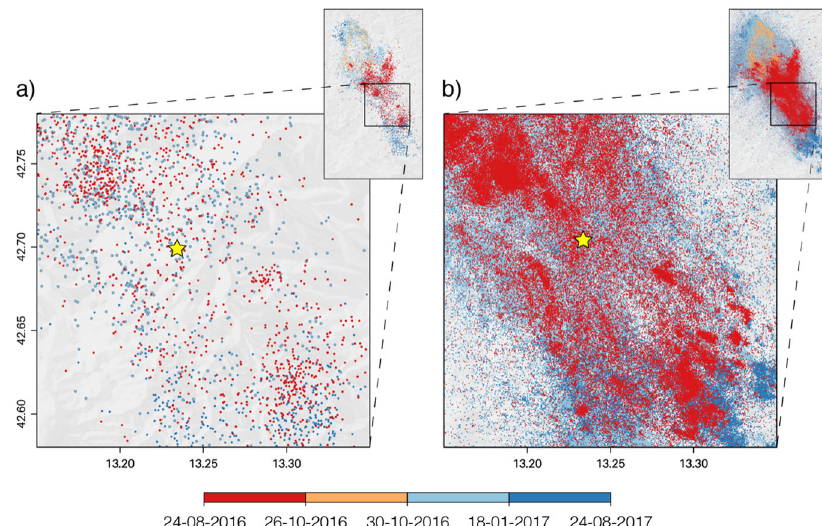
Fig. 1 A year of seismicity in the epicentral area of the 2016 M = 6.0 Amatrice earthquake (star) in Italy color coded by time of occurrence. a Real-time catalog, available at http://cnt.rm.ingv.it/ and ( b ) machine-learning catalog 16 are shown for event magnitudes above their respective magnitude of completeness 12,16 Mc = 2.2 and Mc =